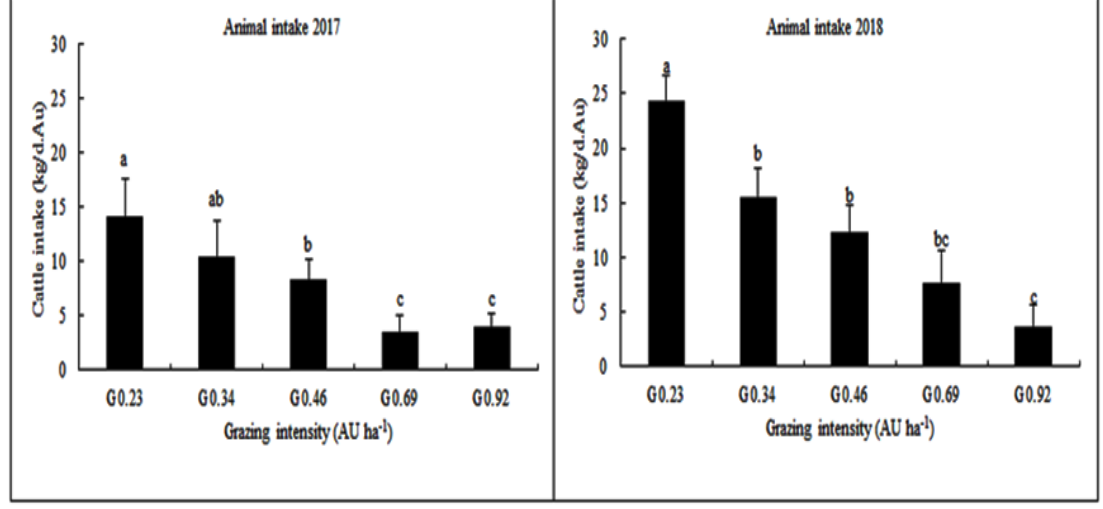
ff ect of grazing intensity and season on dry matter intake (DMI). a, b, c, means followed Figure 5. The effect of grazing intensity and season on dry matter intake (DMI). Figure 5. The e by the same small letters are not significantly di ff erent ( p < 0.05).